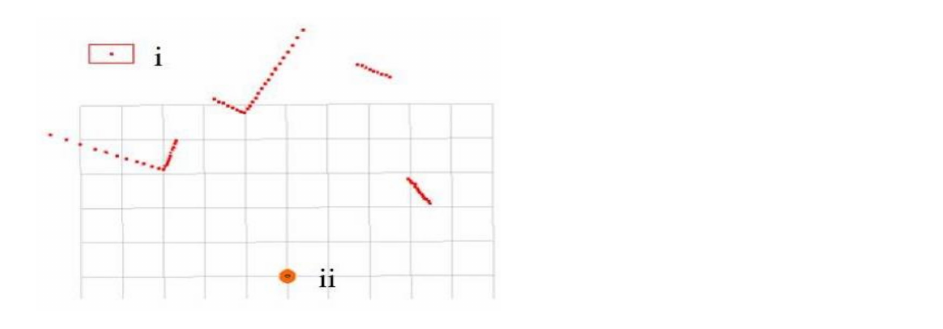
Figure 8. A frame of LiDAR scanning in the simulation environment. The points in the figure represent the point cloud of obstacles. (i) Indicates an abnormal laser point; (ii) refers to a robot. The side length of each grid is 1 m.